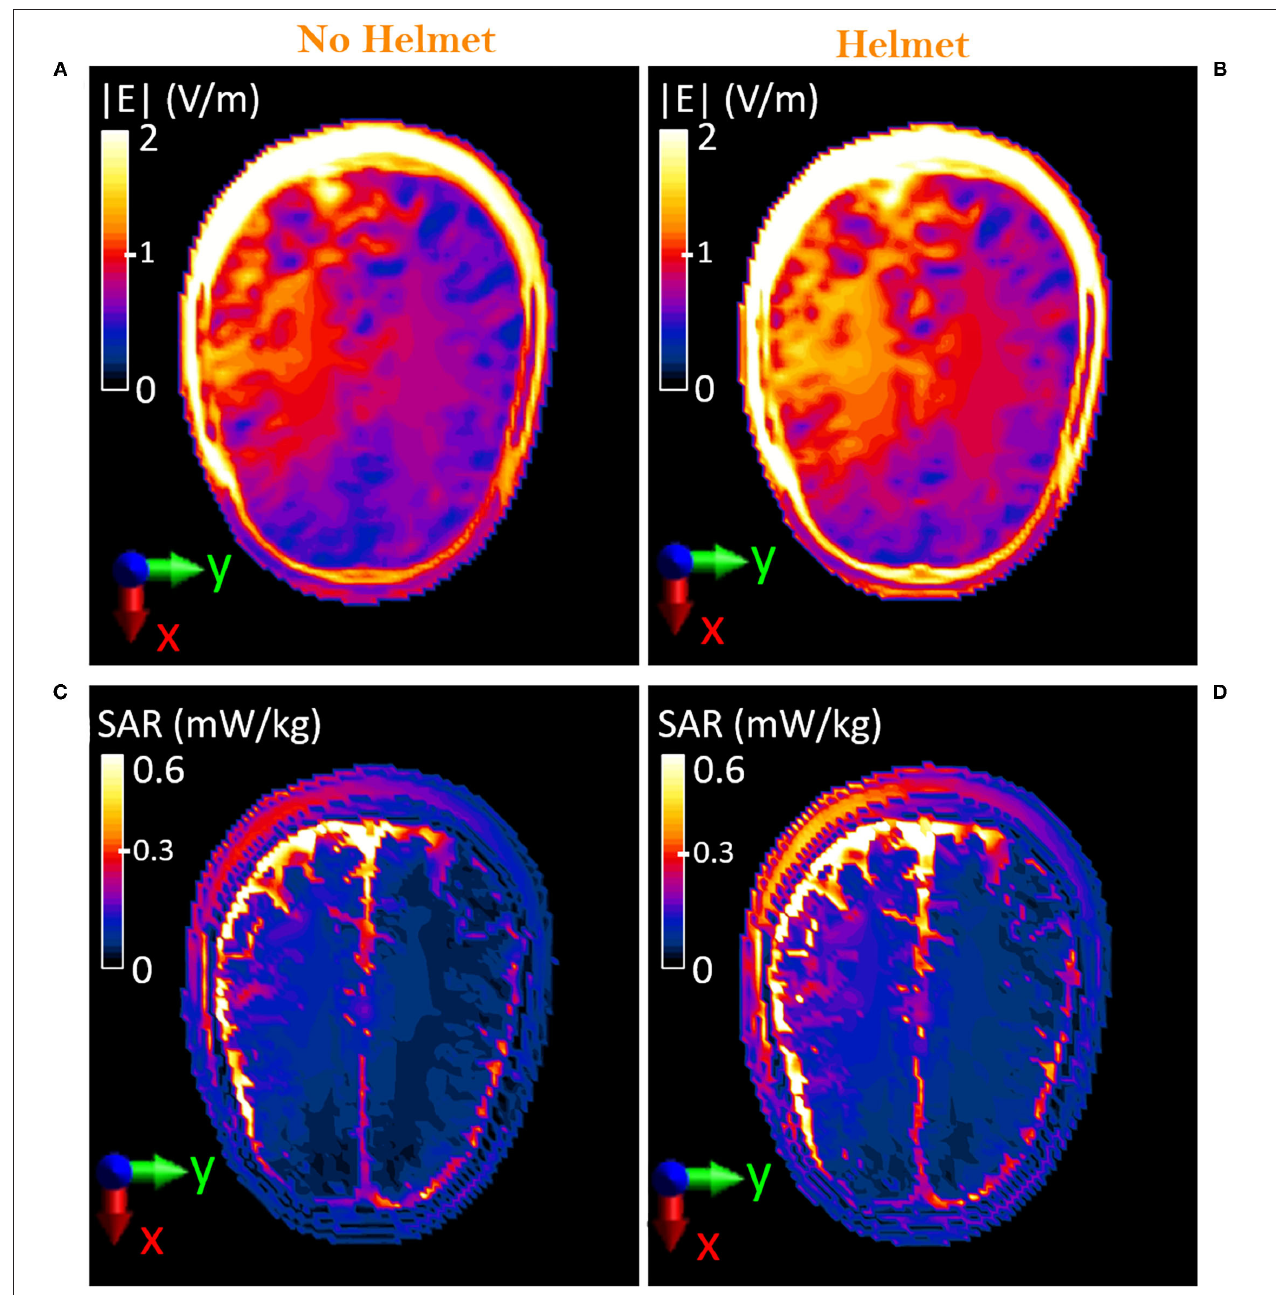
FIGURE 6 | Comparison on the axial plane, XY, between unequipped and equipped military operator, (XY plane): (A,B) Distribution of the E-field induced inside the head of the virtual body model Duke at 70cm from the manhole. (C,D) Distribution of the local SAR induced inside the head of the virtual body model Duke at 70cm from the